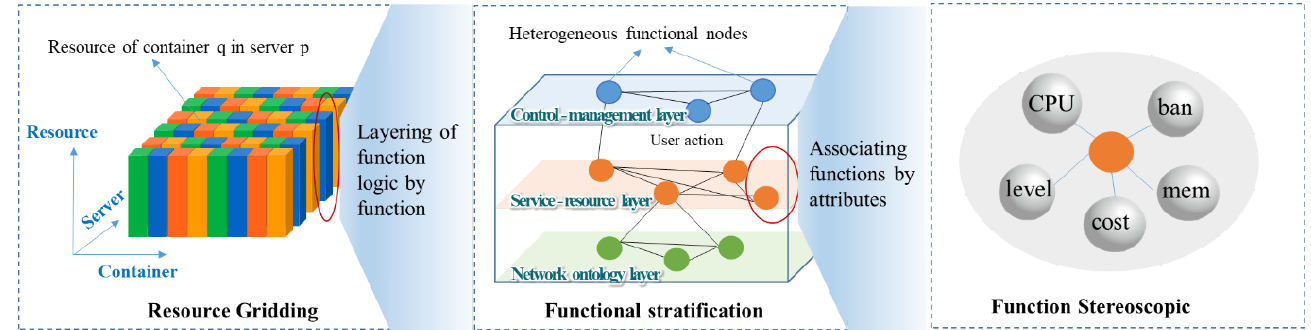
Figure 4. The three-dimensional hierarchical simulation framework.